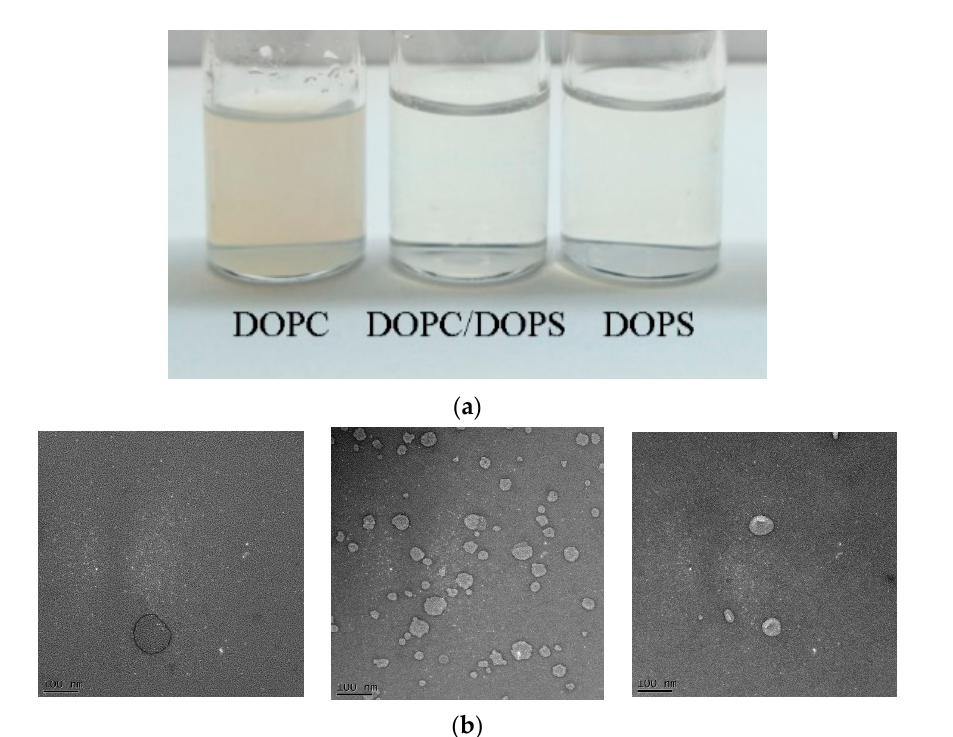
Figure 2. Optimization and characterization of the belinostat-loaded liposome delivery system. ( a ) Observation of the belinostat-loaded liposome delivery system. ( b ) Transmission electron microscopy (TEM) images of belinostat-loaded liposomes with DOPC, DOPS, or mixed DOPC/DOPS groups (left to right).